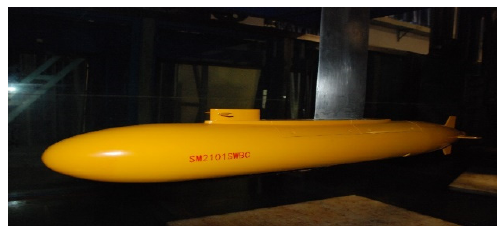
Figure 5. Experimental model of underwater vehicle.